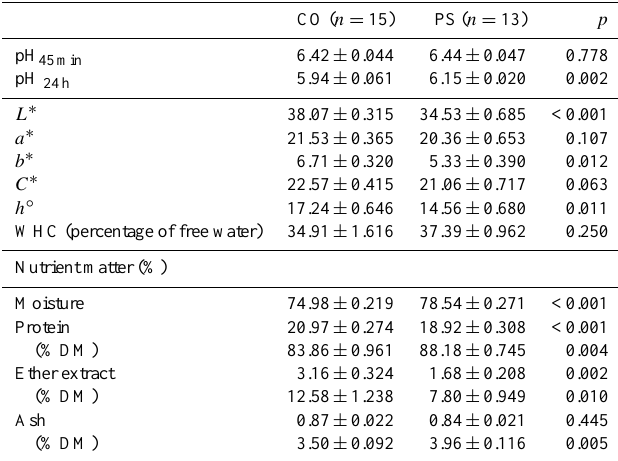
Table 2. Means for slaughter and carcass traits of concentrate (CO) and pasture lambs (PS).